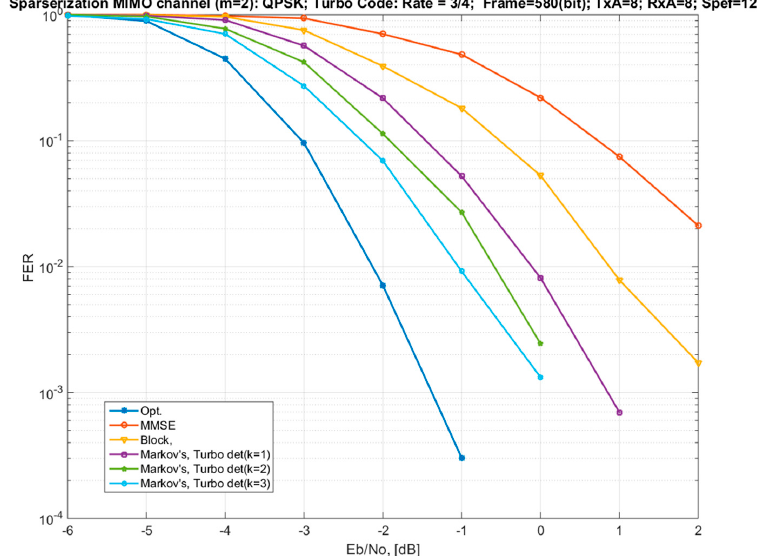
Figure 6. Dependences of the FER on the signal-to-noise ratio per bit for an 8 × 8 MIMO channel with different options for the channel matrix sparsification and with different detectors (QPSK modulation and Turbo code with a rate of